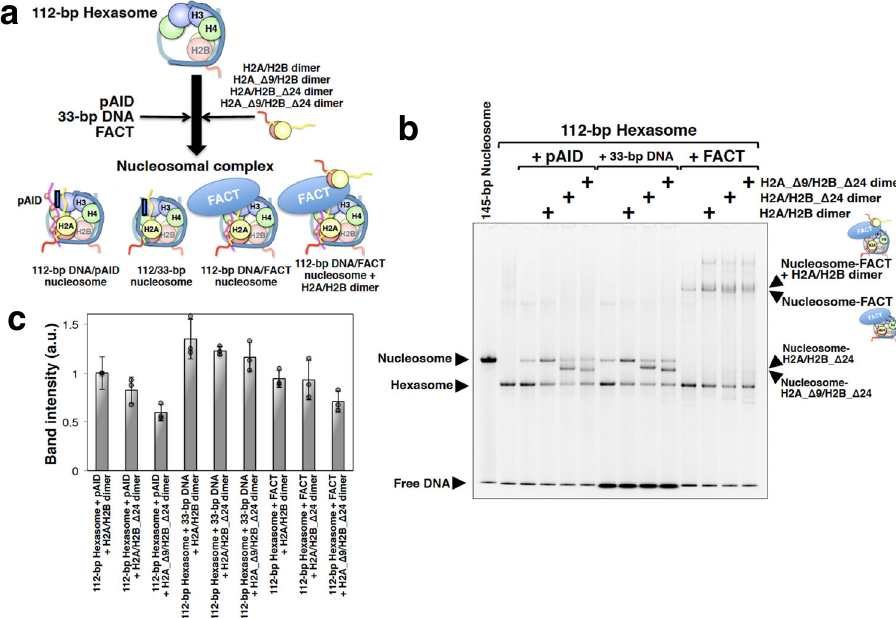
Fig. 6 H2A and H2B N-tails play an important role in nucleosome assembly with hFACT. a Cartoon model of the nucleosomal complex. Histone proteins and DNA are colored as follows: H2B (red), H2A (yellow), H3 (light blue), H4 (green), and DNA (light sea green). The H2A and H2B N-tails are indicated by yellow and red strings, respectively. pAID is colored magenta. Red circles labeled with P indicate phosphorylation. hFACT is colored blue. b Representative SYBR Gold-stained EMSAs of nucleosomal complexes in each mixture. Experiments were repeated at least three times. The full gel image is shown in Supplementary Fig. 13. In lanes 3, 5, 6, 7, 9, and 10, a faint band consistent with a full nucleosome band is observed. The reconstitution of the 112-bp hexasome by the salt dialysis method could not prevent yielding a small quantity of the 112-bp nucleosome, comprising a histone octamer and 112- bp DNA. The faint band in lanes 3, 5, and 6 is likely to correspond to its complex with additional pAID, and the faint band in lanes 7, 9, and 10 may correspond to its complex with additional 33-bp DNA. Also, the faint band in lane 11 is likely to correspond to the 112-bp nucleosome interacting with hFACT. c Band intensity of each nucleosomal complex in b . Band intensity was quanti fi ed by using Image Lab software (Bio-Rad), and the intensity of the 112-bp hexasome with pAID and H2A/H2B dimer was set to one. Averages from at least three independent experiments are shown; error bars represent SD.